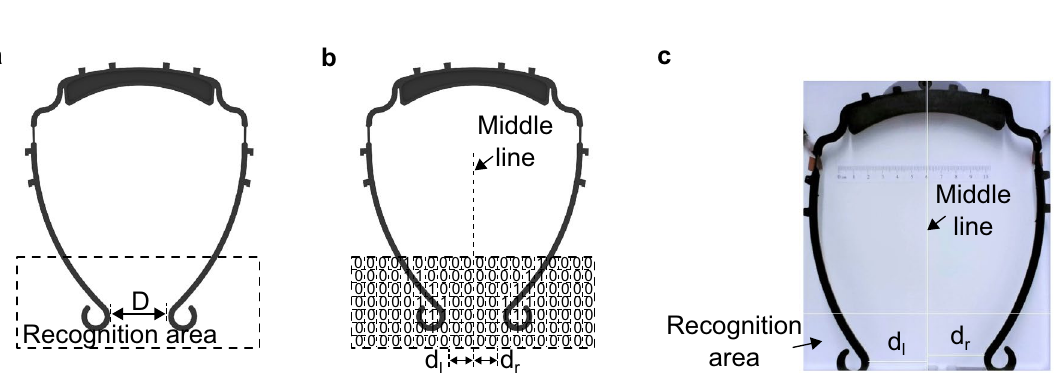
Figure 4. Image processing. ( a ) Image recognition area. ( b ) Recognized visor boundary. ( c ) Camera view with image processing